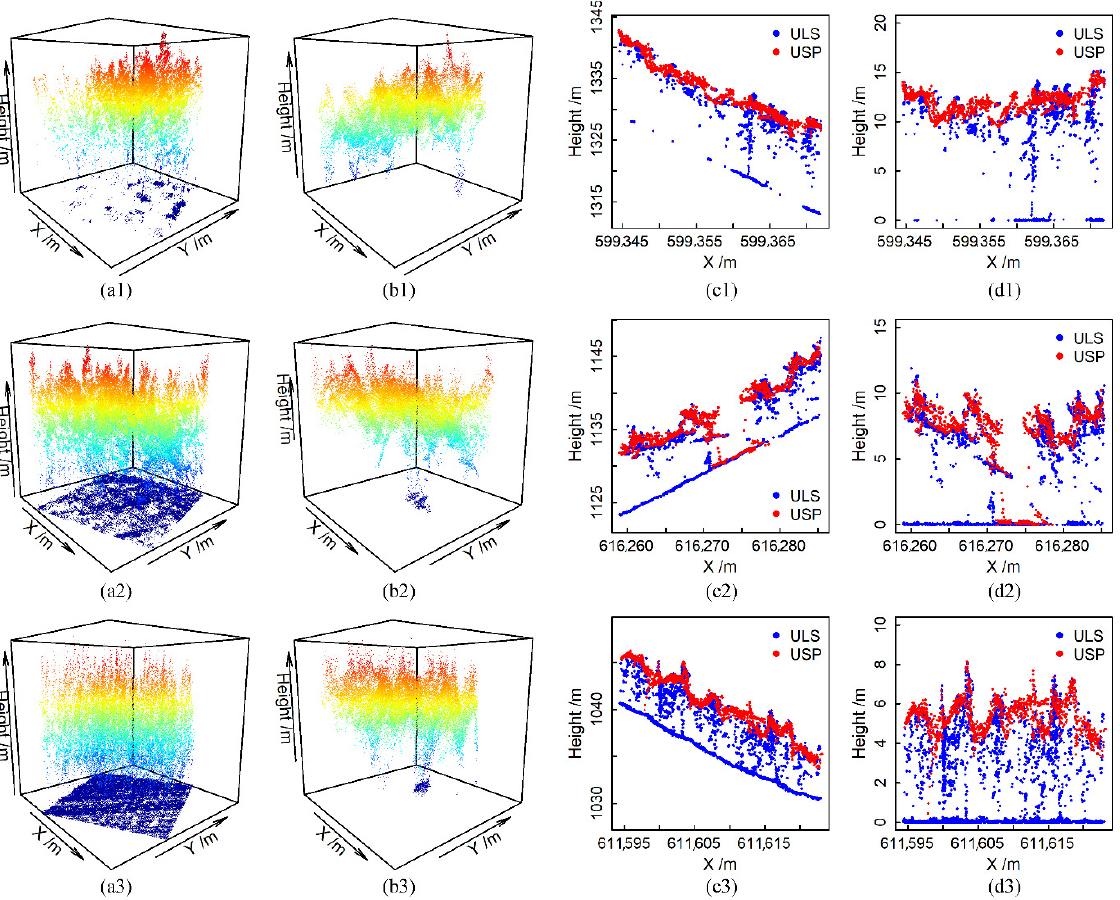
Figure 6. Comparison of the ULS point clouds and USP point clouds within different CC. 3D distribution of ULS point clouds ( a1 – a3 ), 3D distribution of USP point clouds ( b1 – b3 ), the original point cloud profile within a transect of 1 m width ( c1 – c3 ), and the normalized point cloud profile within a transect of 1 m width ( d1 – d3 ).